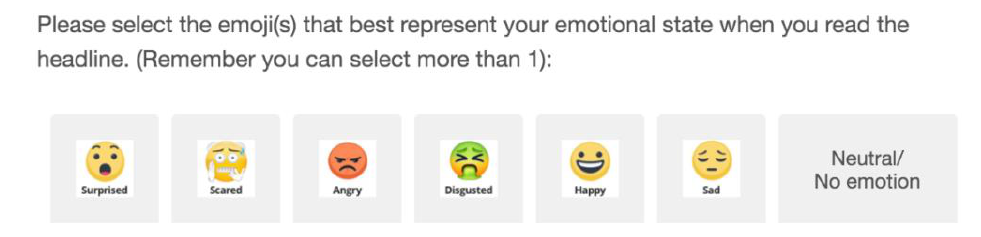
Figure 4. Survey question measuring emotional response with emoji response